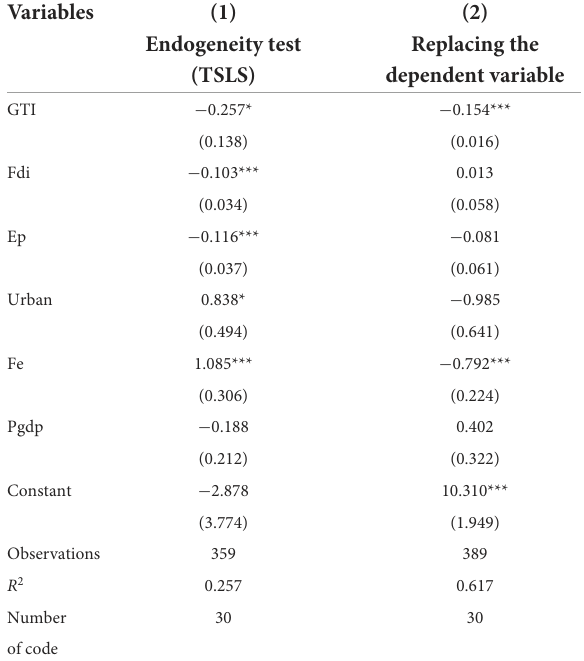
TABLE 6 Robustness